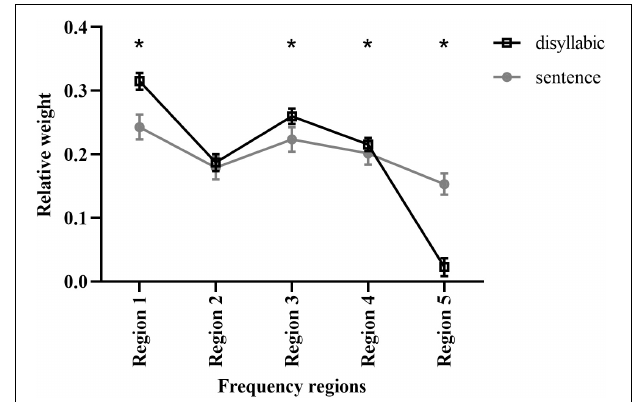
FIGURE 4 | The relative weights of different frequency regions for Mandarin disyllabic word and sentence recognition using acoustic temporal envelope. The data for Mandarin sentence recognition was adopted from a previous study (Guo et al., 2017). The error bars represent standard errors. * Statistically significant ( p <